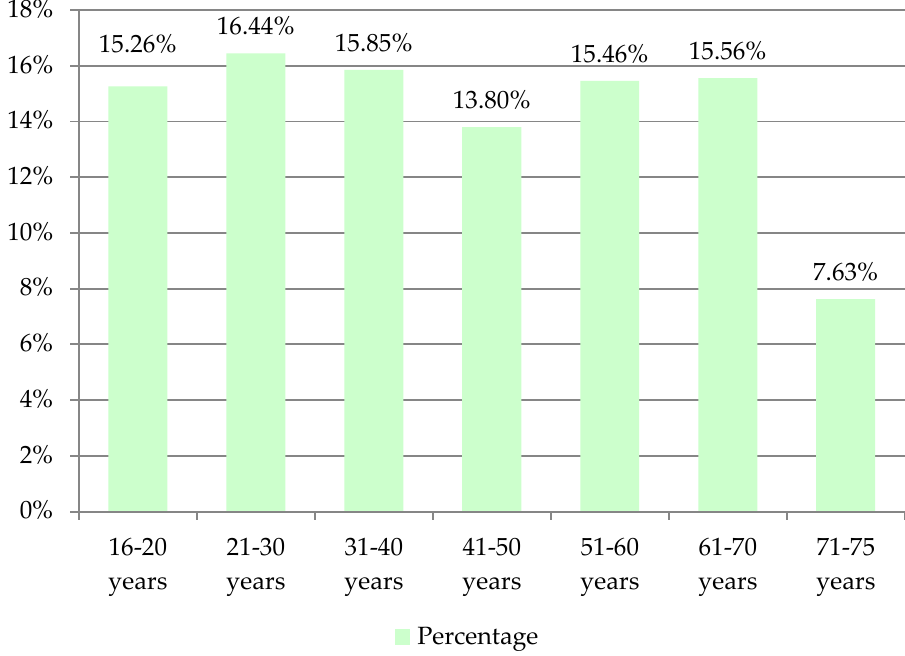
Figure 1. The gender structure of the respondents.